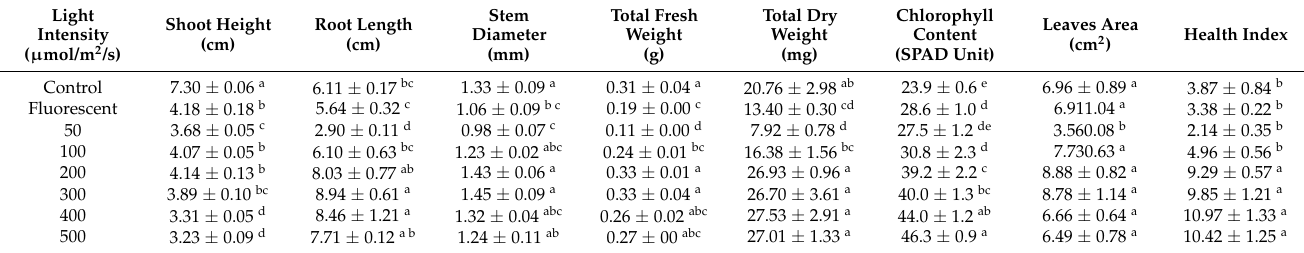
Table 2. Effect of different light intensities on tomato seedling growth.